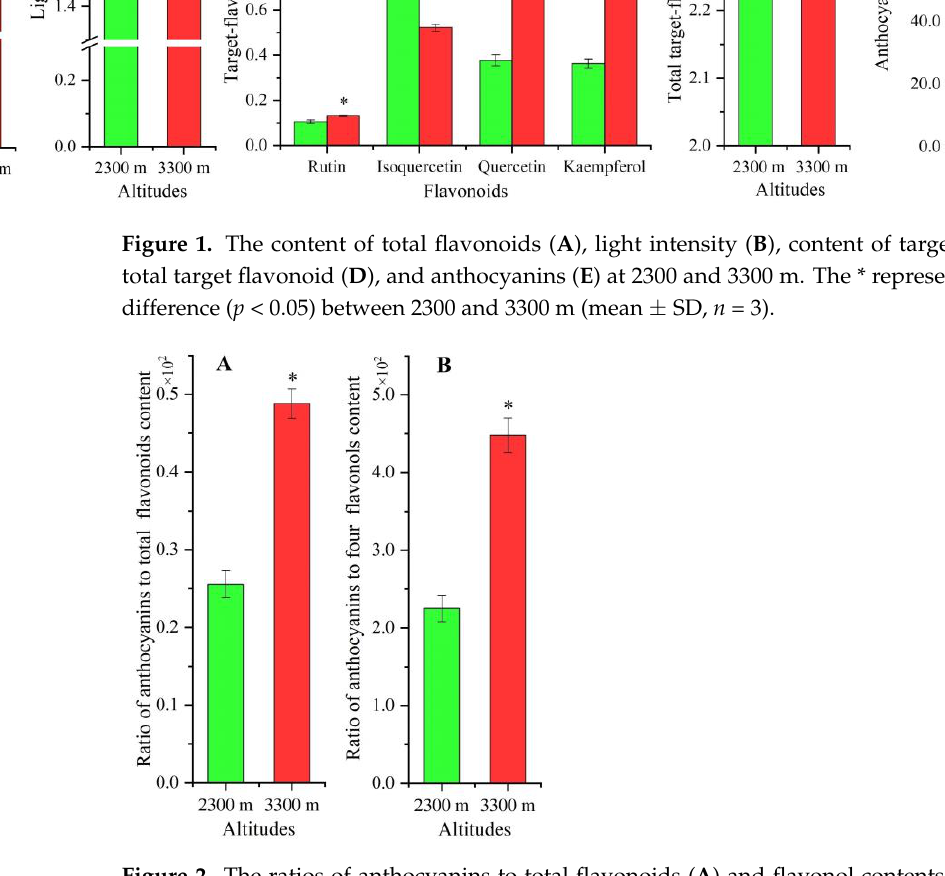
Figure 2. The ratios of anthocyanins to total flavonoids ( A ) and flavonol contents ( B ) at 2300 and 3300 m. The * represents a significant difference ( p < 0.05) between 2300 and 3300 m (mean ± SD, n = 3).